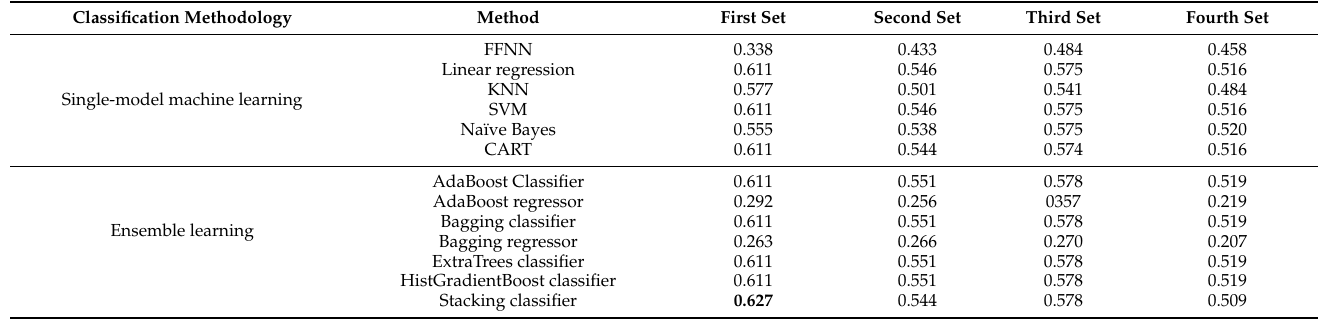
Table 5 represents the accuracies of single model machine learning and ensemble classifiers with different sets of emotions (from Table 3) on the SemEval-2017 dataset us- ing three-class classification. The best overall accuracy was achieved by the stacking clas- sifier on the first set of emotions (0.627). Table 5. Accuracy of classifiers on the SemEval-2017 dataset using three-class classification with different sets of emotions. The best result is shown in bold. Classification Methodology